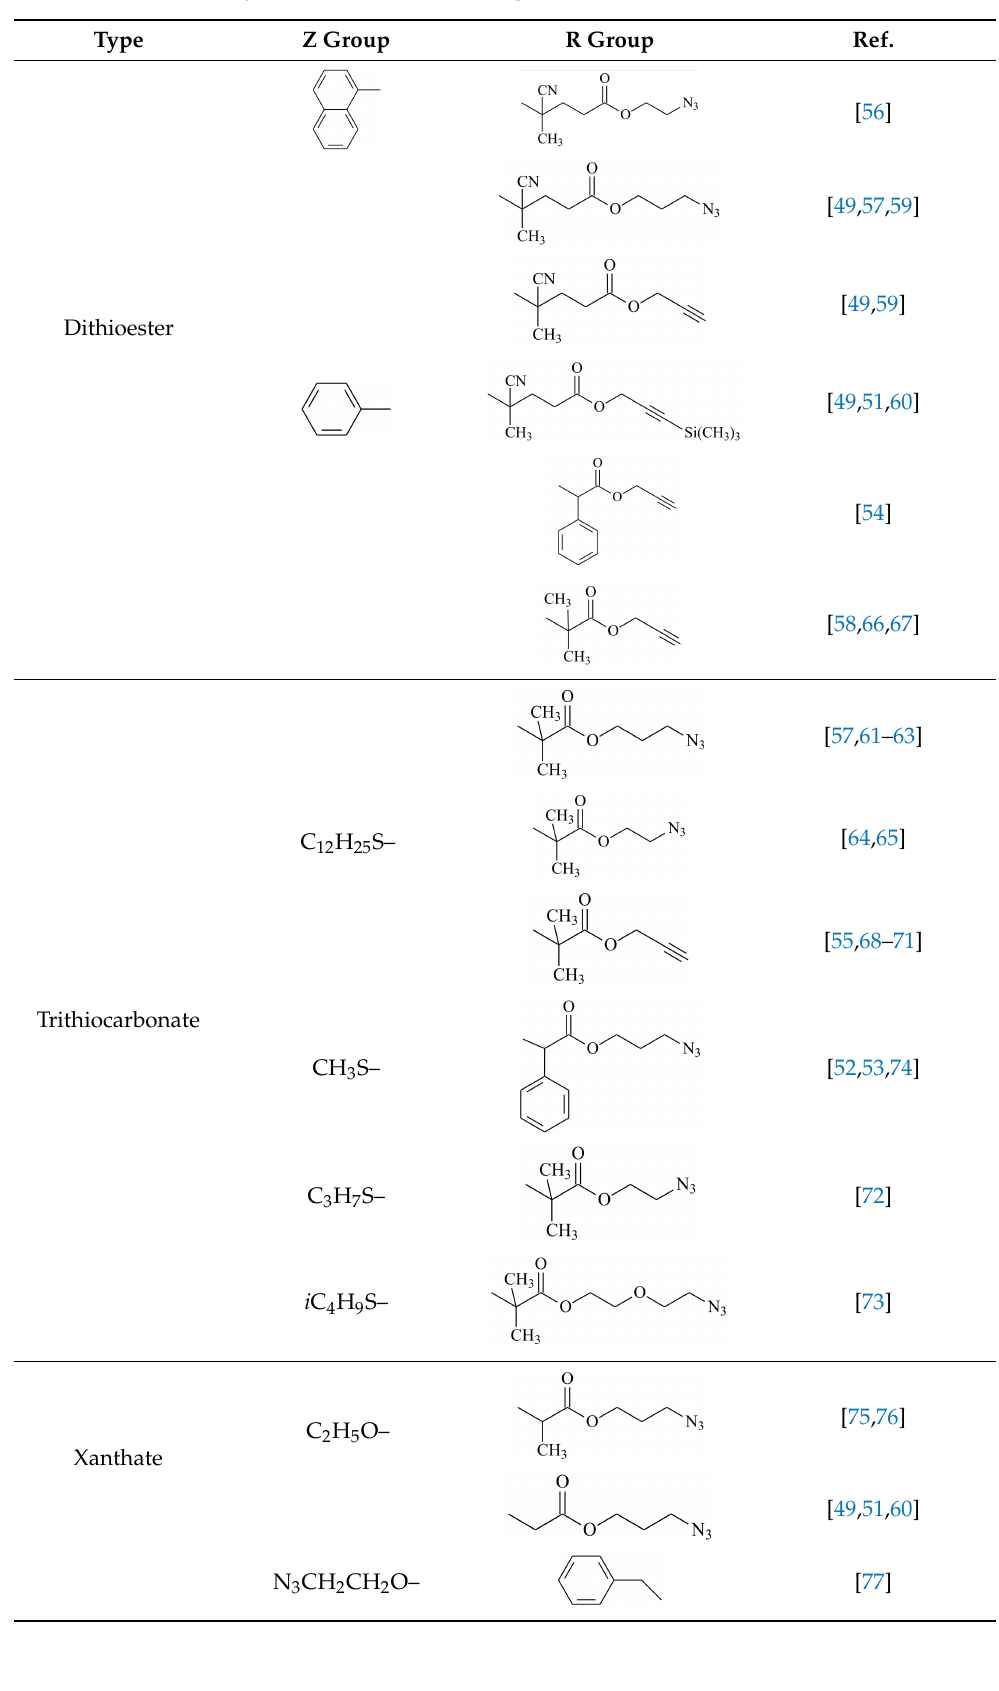
Table 1. Azide- and alkyne-functionalized RAFT